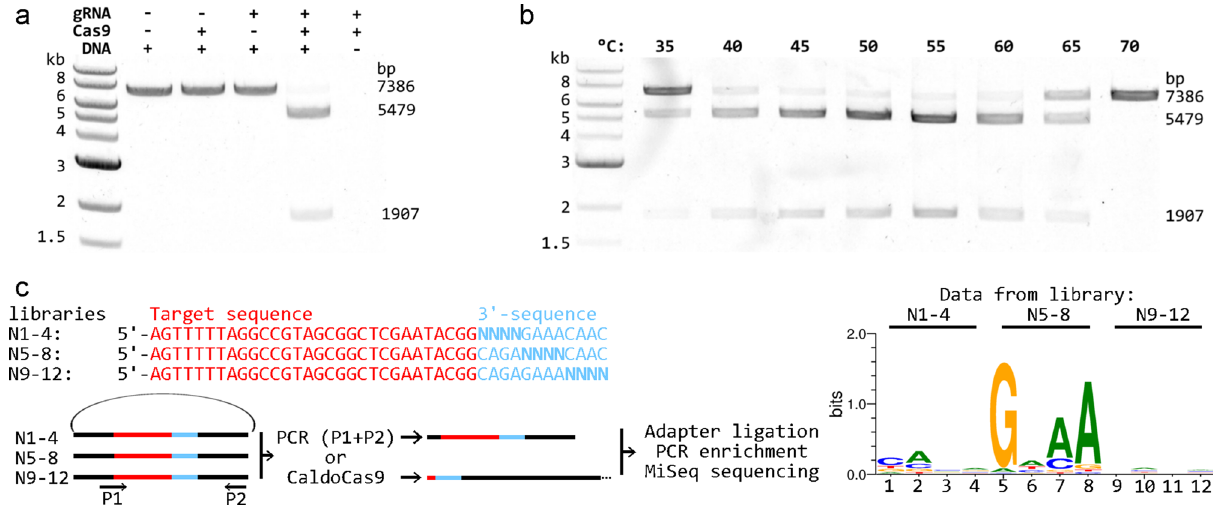
Figure 2. In vitro characterization of CaldoCas9 activity, thermostability and PAM specificity. ( A ) CaldoCas9, a DNA ‘target’ and gRNA containing a spacer complimentary to the target DNA were incubated in various combinations (top, + = with, – = without) at 55 °C and the products separated on an agarose gel. Scale on left corresponds to the DNA ladder in the first well of the gel. On far right are indicated the expected band sizes of the uncut (7386 bp) and cut (5479 and 1907 bp) DNA. ( B ) CaldoCas9, a DNA ‘target’ and gRNA containing a spacer complimentary to the target DNA were incubated together at various temperatures (top) and the products separated on an agarose gel. ( C ) Top-left: three DNA libraries were prepared that contained a ‘target sequence’ that was common to all three libraries (red font) and a partially randomized sequence (3 ′ - sequence, in blue font, randomized bases indicated as N) downstream of the target sequence. Bottom-left: the DNA libraries (carried on a circular plasmid backbone) were separately PCR amplified (primers indicated as P1 and P2) and incubated with CaldoCas9 and gRNA. The products of each were adapter ligated, PCR enriched and sequenced. Right: PAM sequences permissible for CaldoCas9 cleavage, as revealed by the